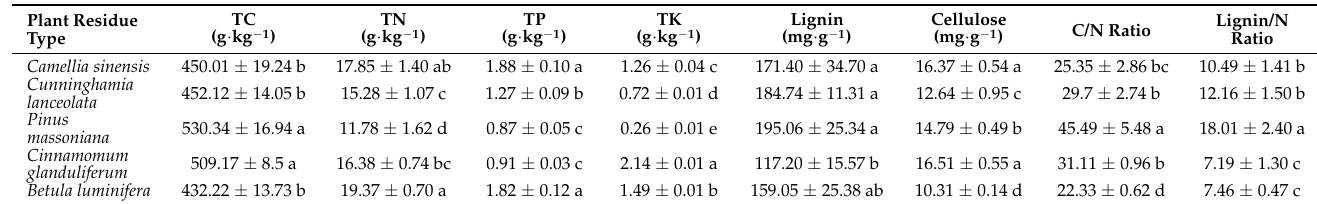
Table 1. Inceptive nutrients in the plant residues used for